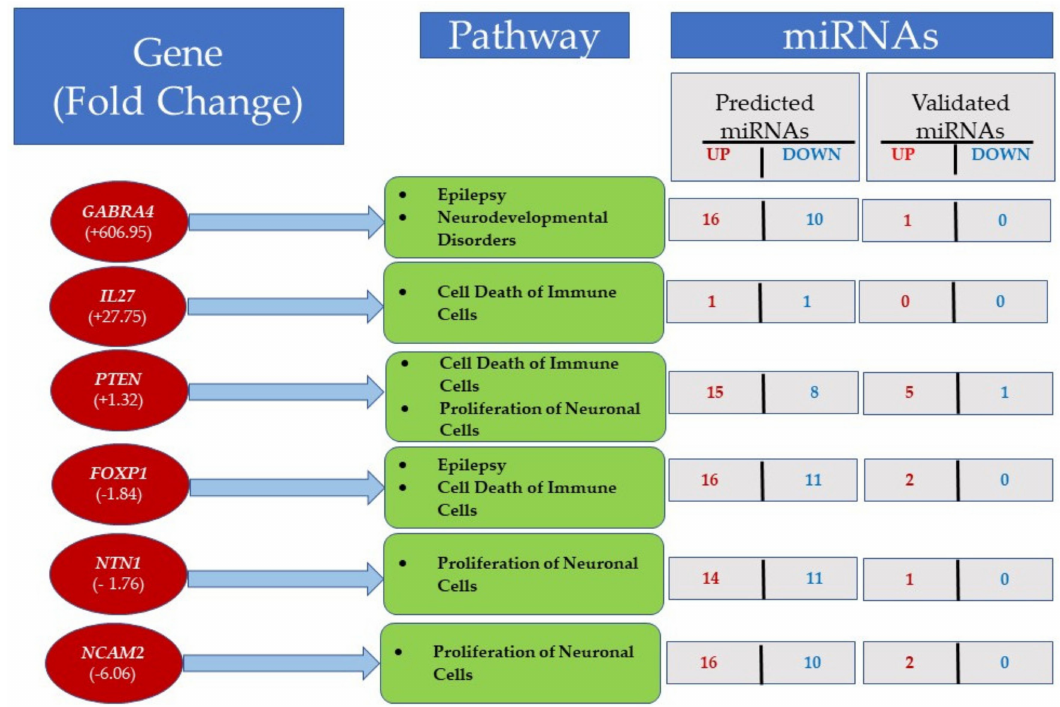
Figure 8. mRNA–miRNA interactions were predicted using differentially expressed genes targeted by miRNAs with miRWalk2.0. The figure shows some important pathways in LCLs, along with the number of predicted and validated miRNAs. For details see Table